Question: Give a one-sentence summary of this figure.
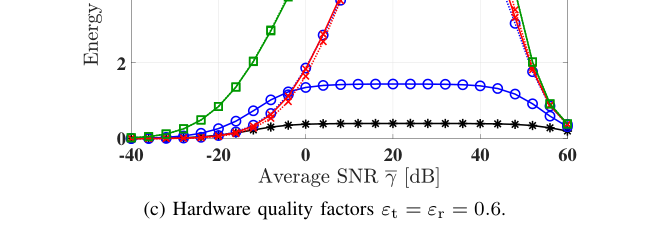
Answer: Comparison of the energy efficiency versus the average SNR γ in various beamforming schemes.